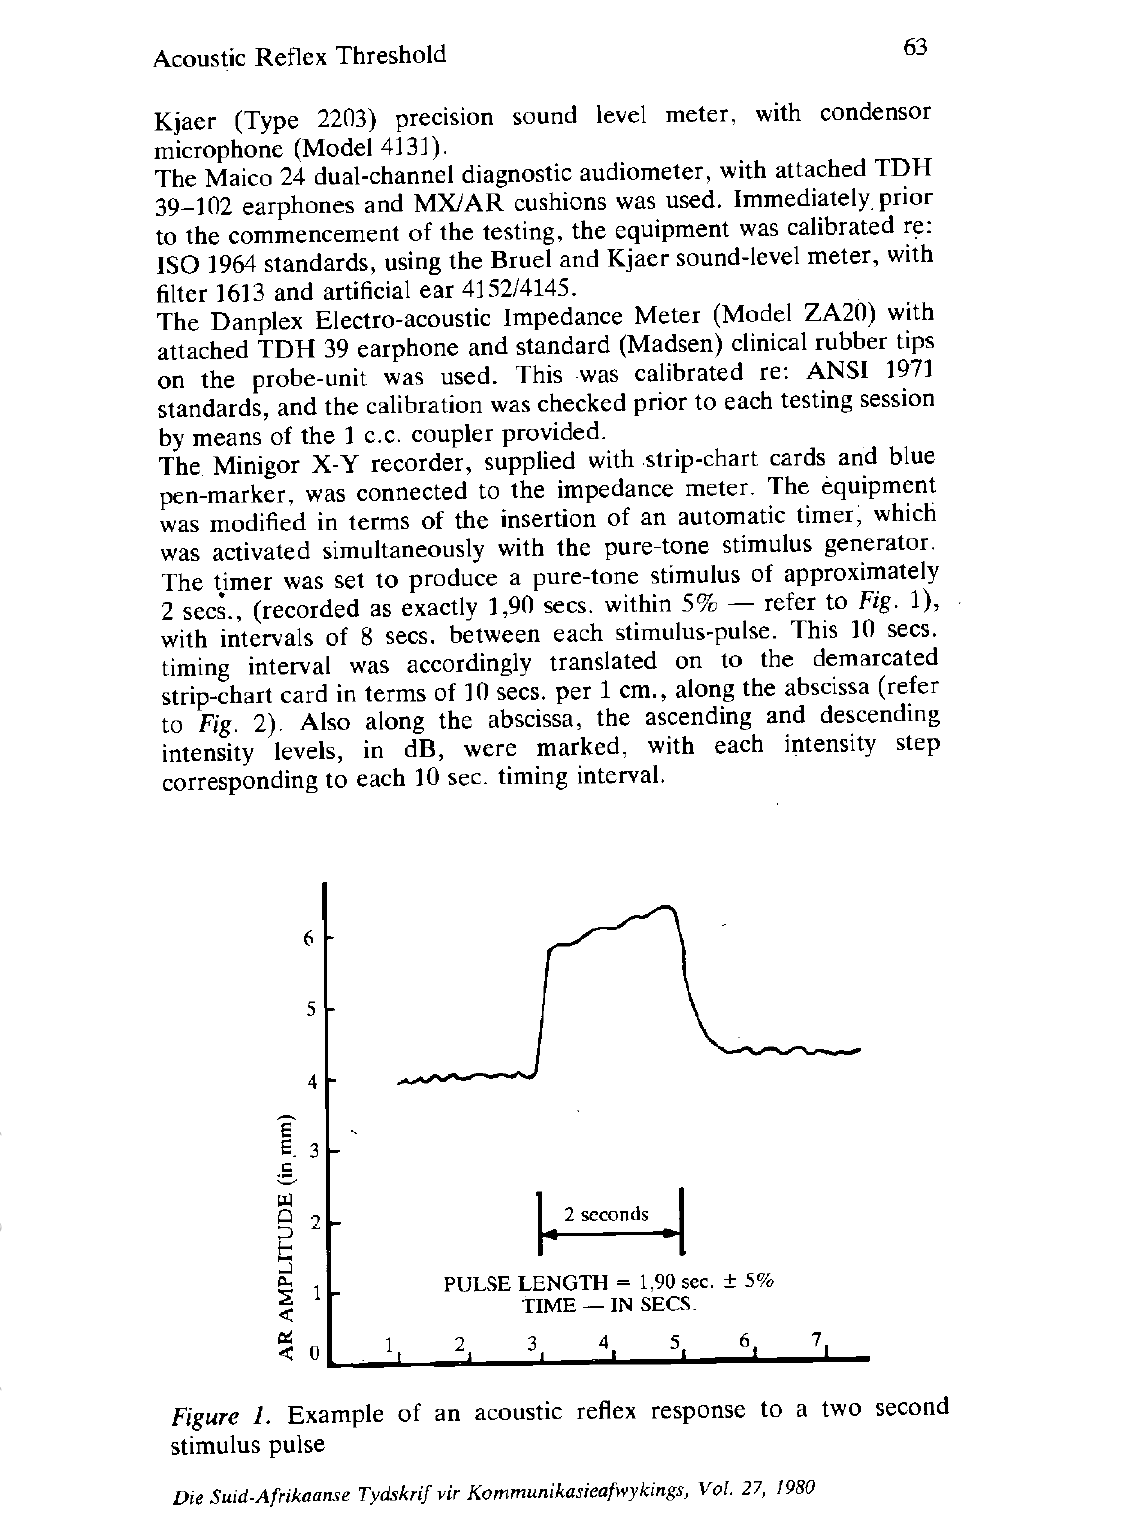
Figure 1. Example of an acoustic reflex response to a two second stimulus